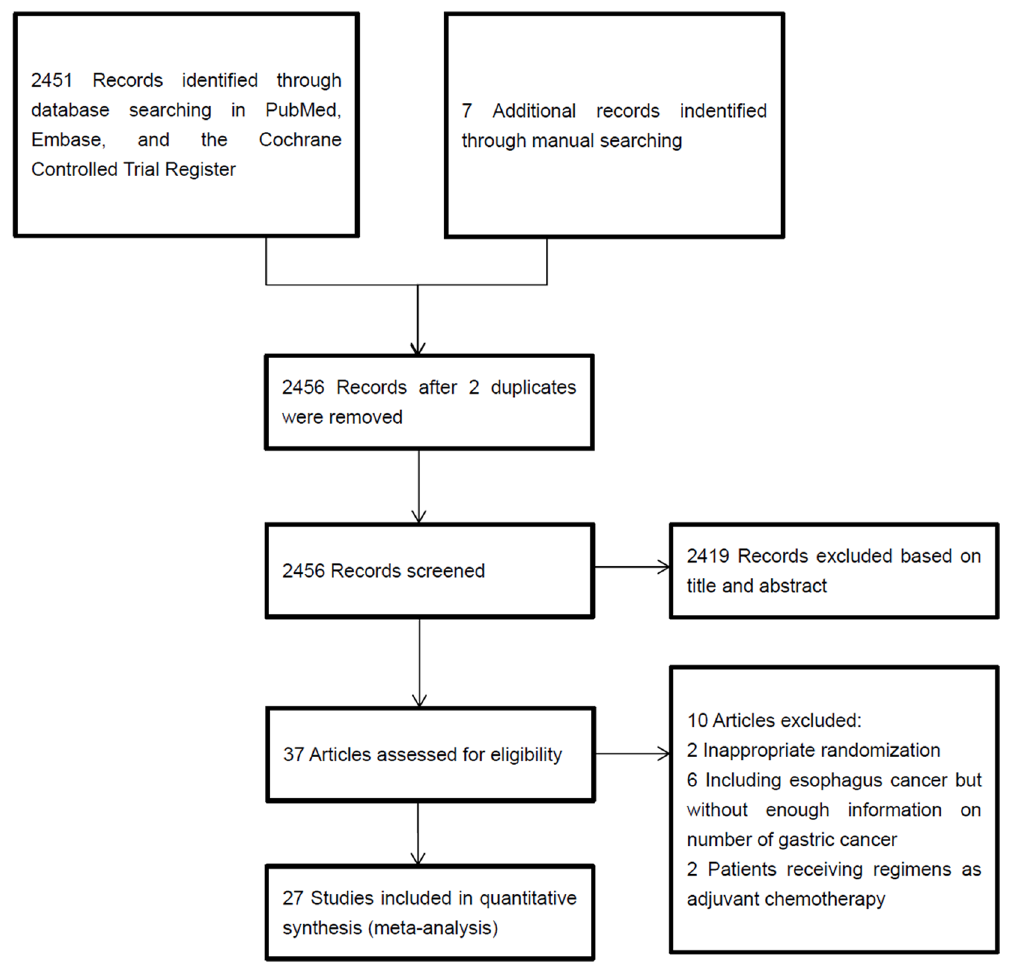
Figure 1. Selection of Articles for Meta-Analysis.